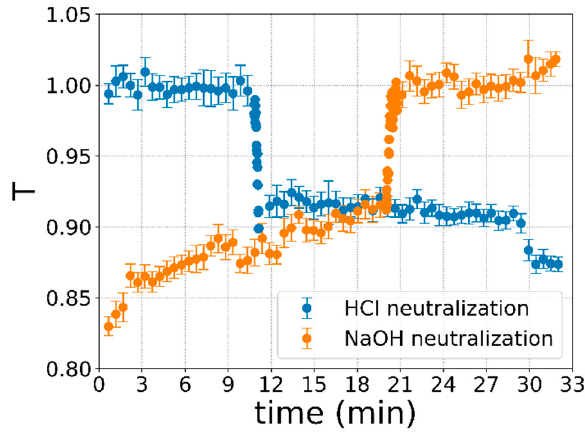
Figure 8. Optical transmission responses from the waveguide on the optofluidic chip, obtained using the flowrate recipes of Table 2. The orange data correspond to the neutralization process of NaOH, whereas the blue ones correspond to the HCl. For the purpose of clarity, the data are smoothed considering an average every 20 s and the related standard deviation as the error, except for the abrupt transition in the correspondence of the pH indicator equivalence point.